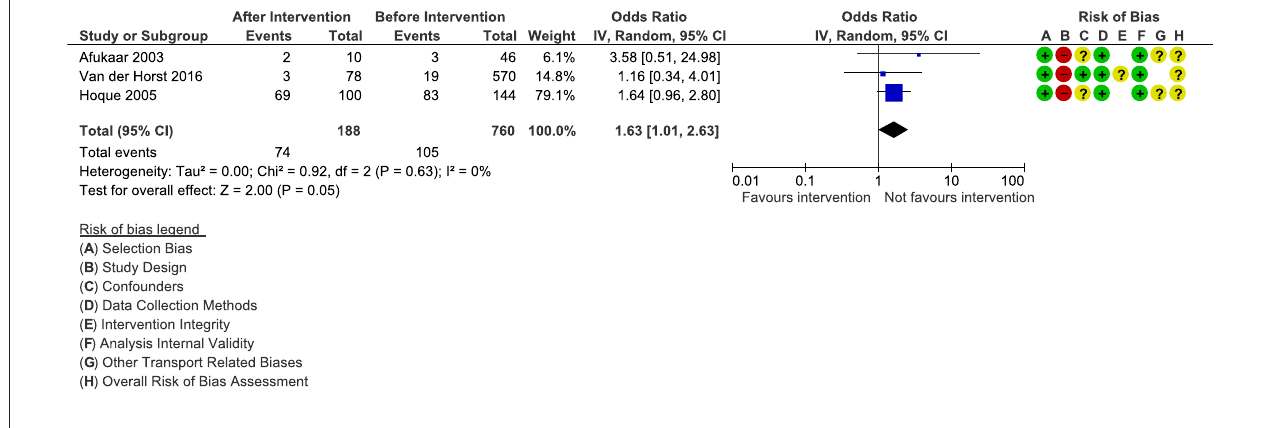
FIGURE 2 | Primary outcome: changes in ‘road traffic death counts’ after road engineering interventions.